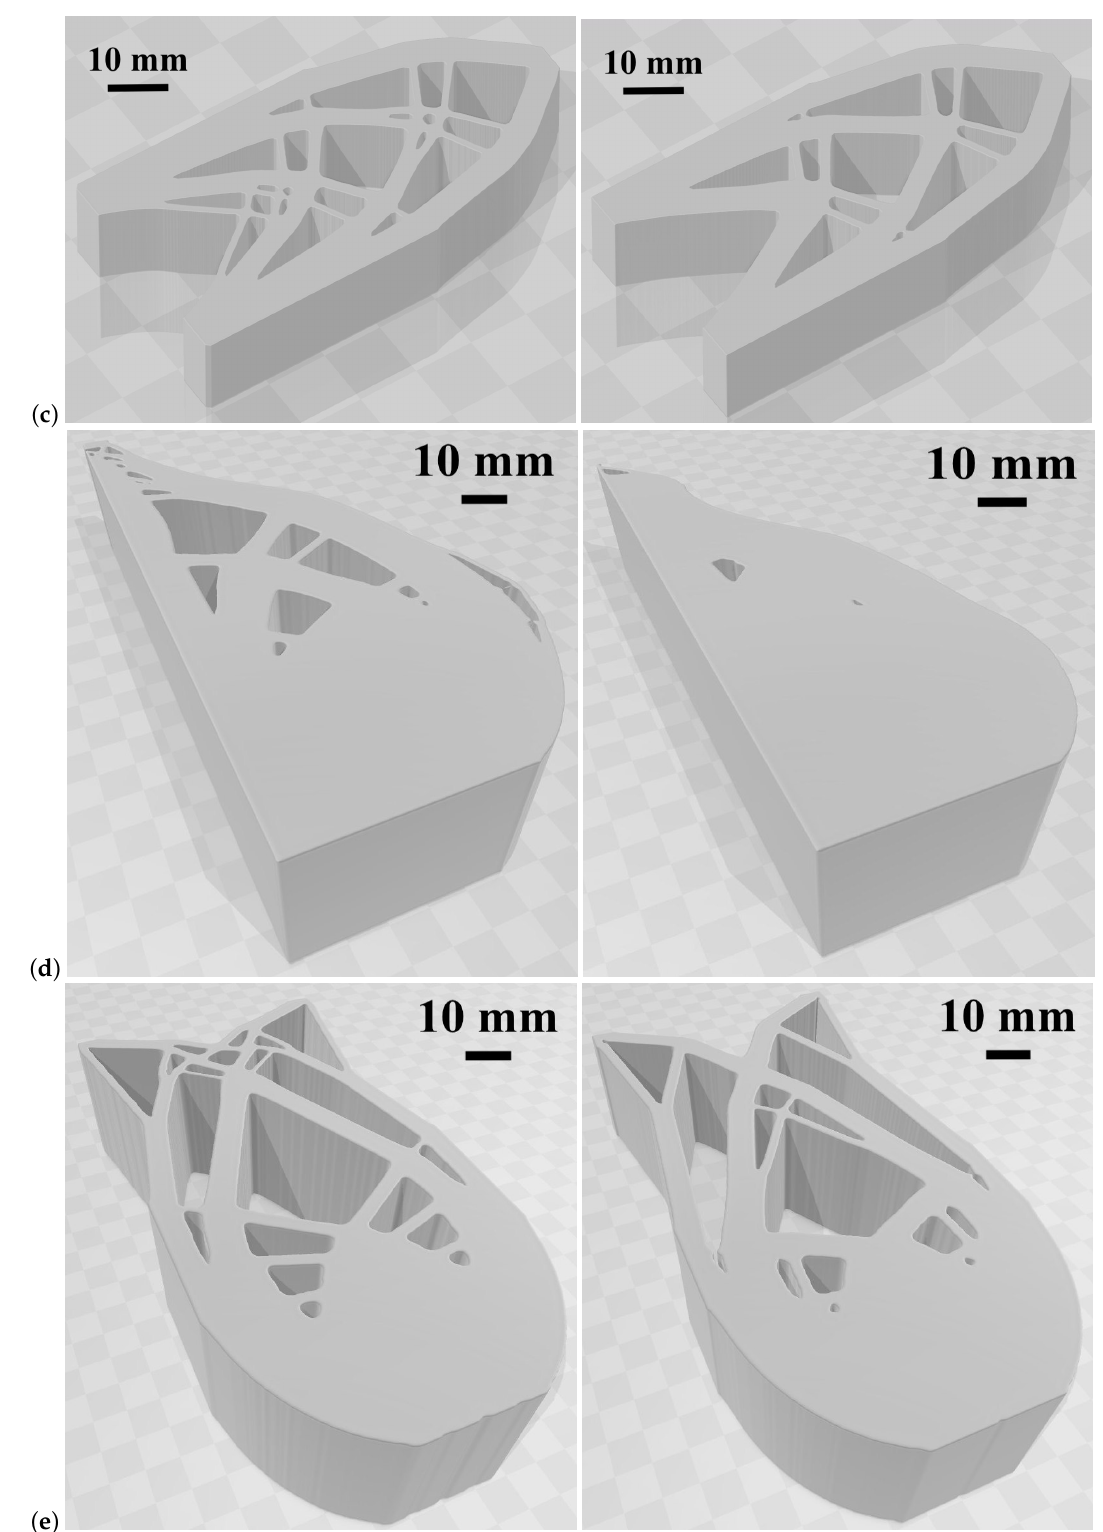
Figure 7. Optimal geometries obtained with modified algorithm ( left ) and original algorithm ( right ) (see Section 3.1): ( a ) the three-point bending beam optimization case; ( b ) the optimization case where the beam is supported horizontally in two bottom points, and equal loads applied vertically in upper corners; ( c ) the cantilever beam optimization case; ( d ) the optimization case where the beam is fixed along the bottom side, and the horizontal load linearly distributed along the left side of the beam; ( e ) the optimization case where the beam is fixed horizontally in two bottom points, and equal loads applied horizontally in upper